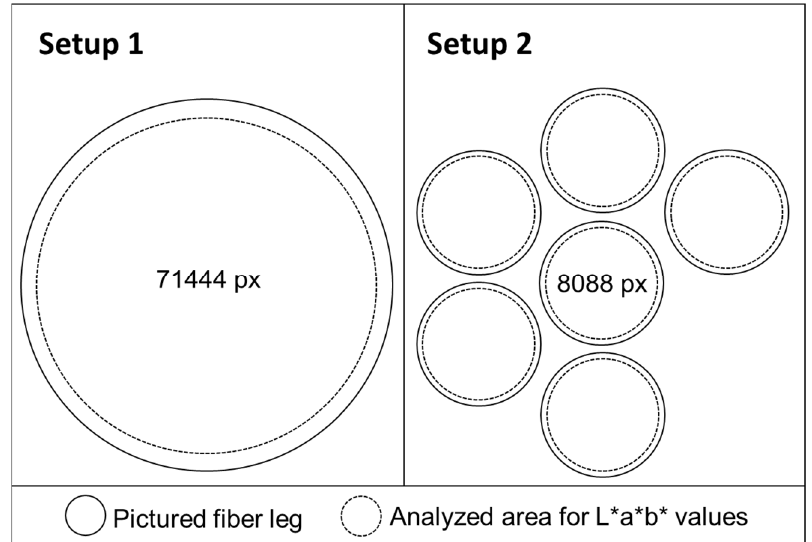
Figure 3. Schematic visualization of the pictured fiber leg for Setup 1 and 2 with the selected area to be analyzed (for Setup 1: 71444 Pixel; and for Setup 2: six fiber legs with each 8088 Pixel) for one filament in Corel PHOTO-PAINT.